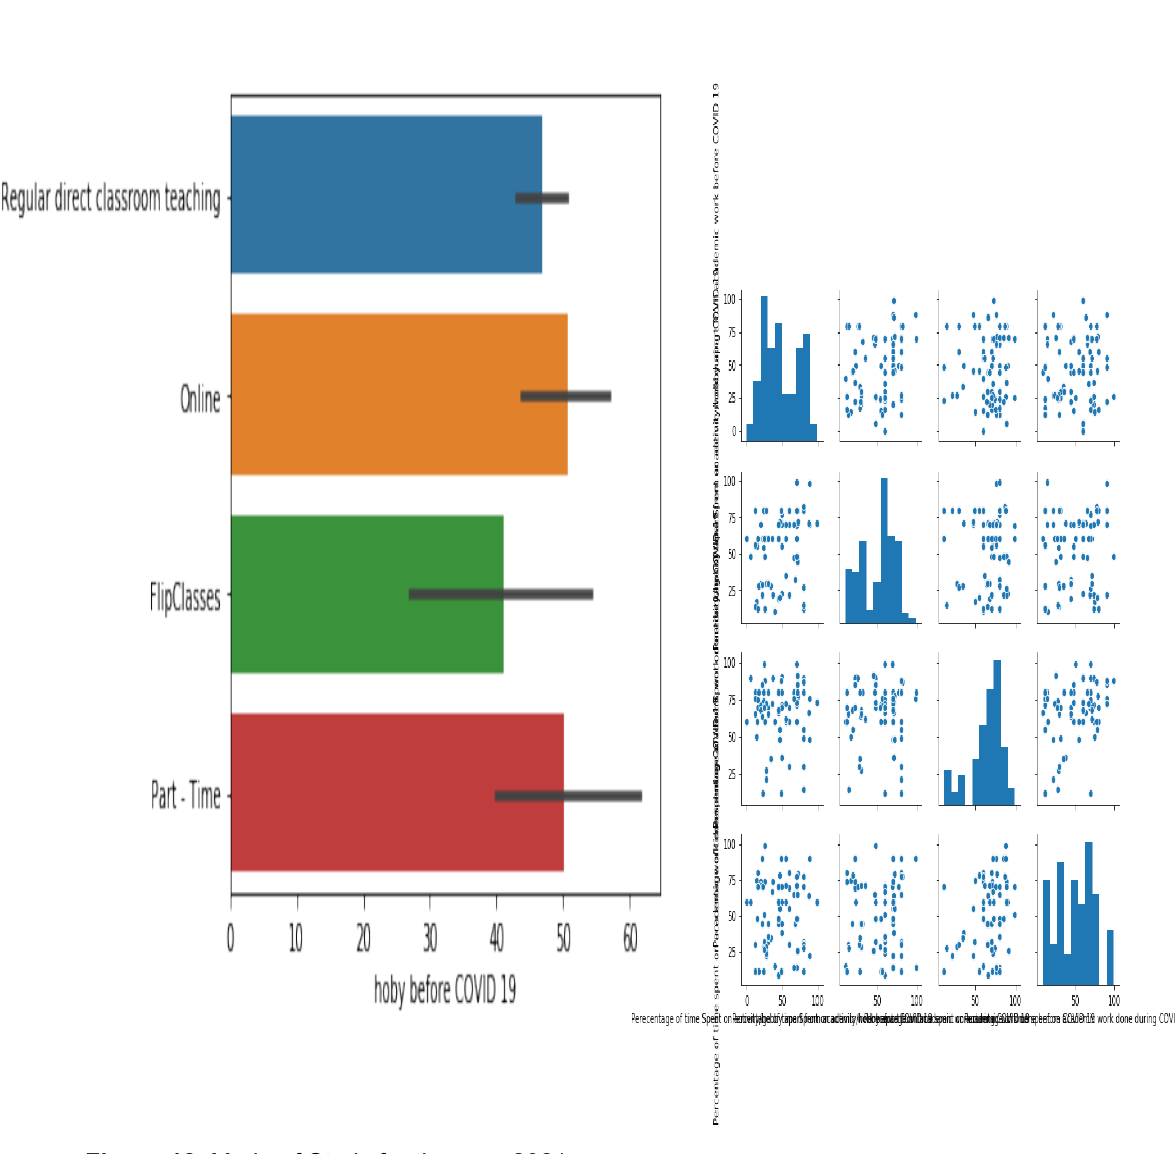
Figure 12. Mode of Study for the year 2021